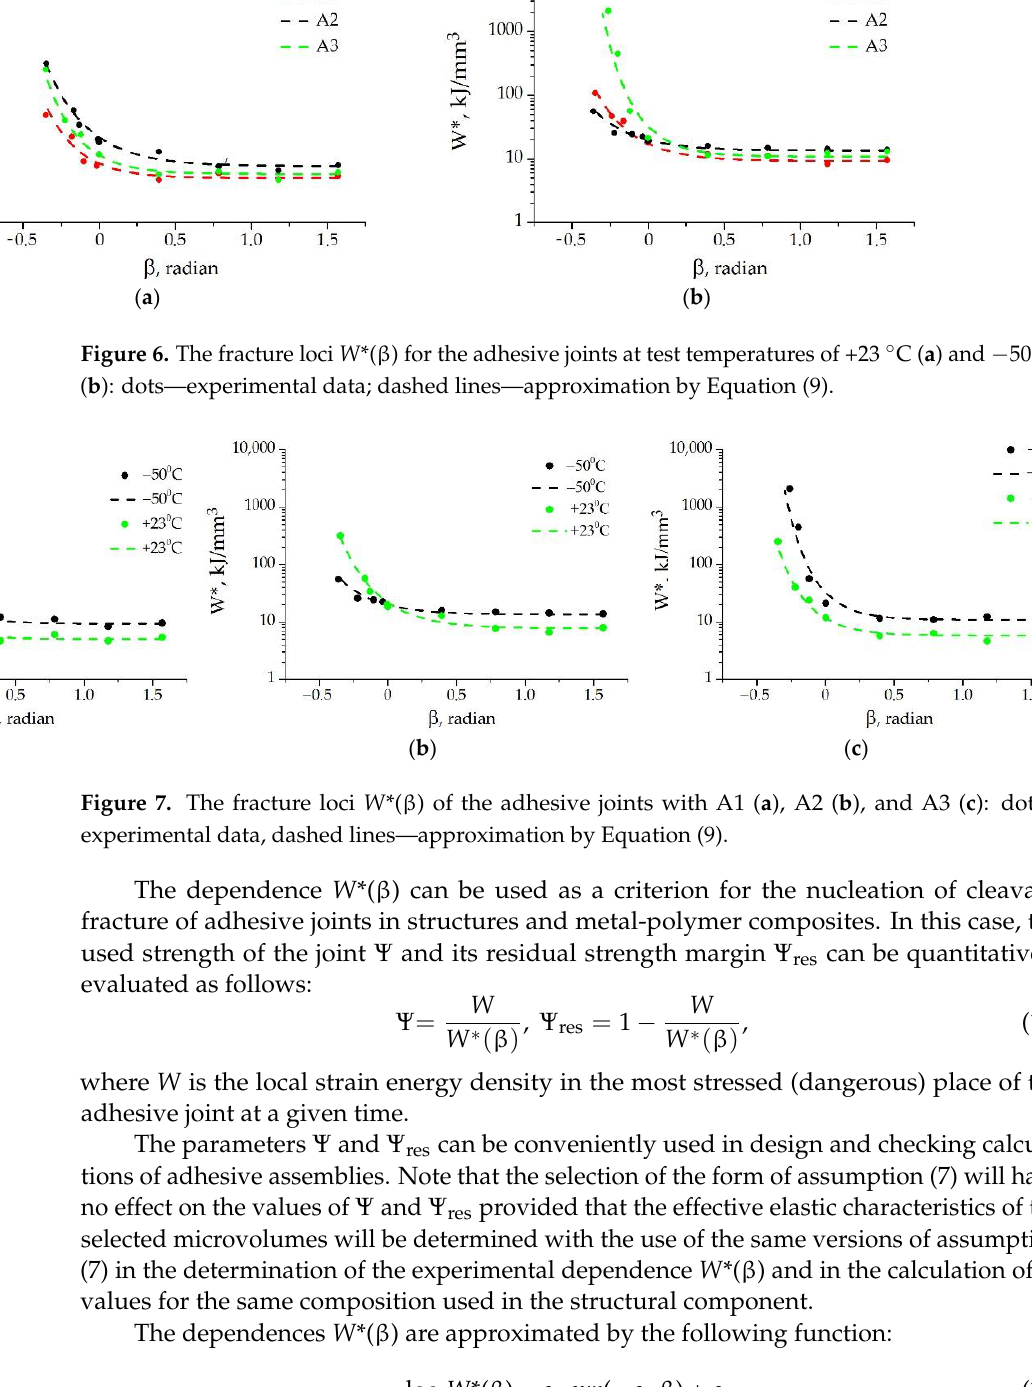
Figure 6. The fracture loci W *( β ) for the adhesive joints at test temperatures of +23 °C ( a ) and −50 °C ( b ): dots — experimental data; dashed lines — approximation by Equation (9).